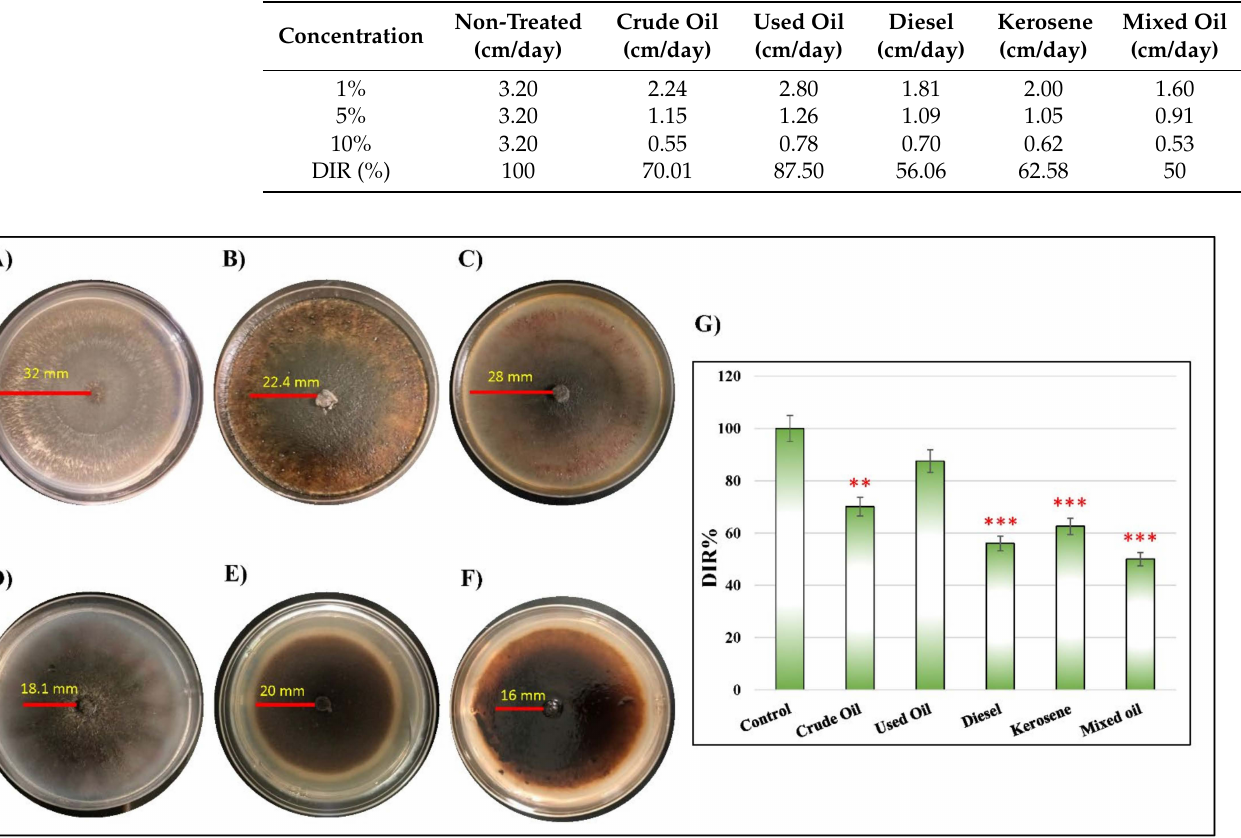
Table 1. The ability of D. spicifera to grow and tolerate different types of petroleum hydrocarbons. The growth rate (cm/day) and the DIR percentages were calculated at 1% concentration of the tested hydrocarbon.